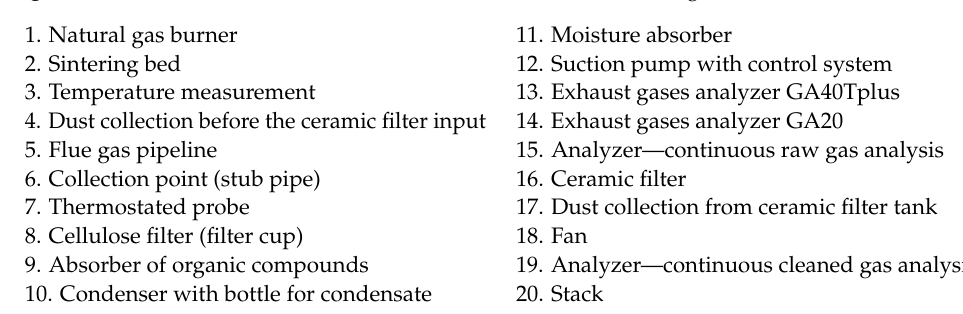
Figure 1. Scheme of the semi-industrial-scale installation for sintering of iron ores.